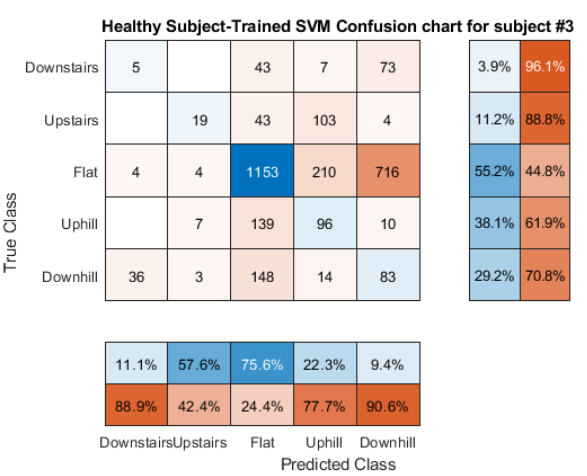
Figure A8. Support Vector Machine Confusion Chart for ILLA participant A2 as trained by healthy in- dividuals.